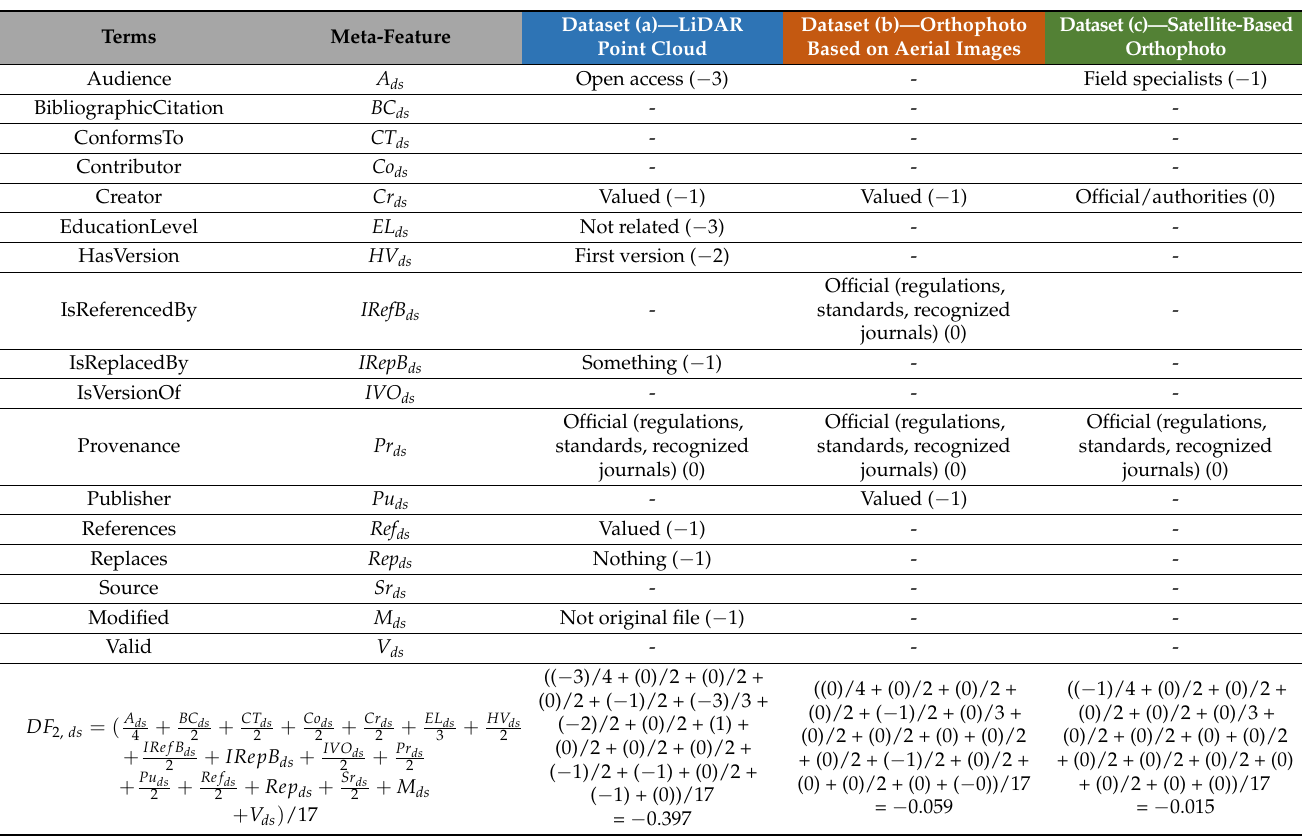
Table 24. Meta-features phase 3— DF 2 per dataset.